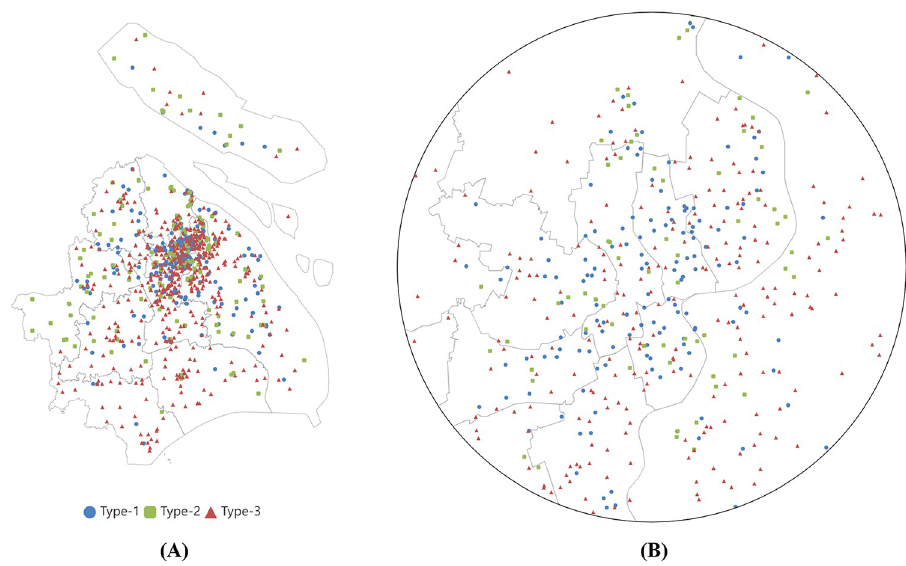
Fig 5. Geographical distribution of PSSFC with three categories in Shanghai. (A) The geographical distribution panorama of PSSFC in Shanghai. (B) The distribution of Type-1 PSSFC in Shanghai. (C) The distribution of Type-2 PSSFC in Shanghai. (D) The distribution of Type-3 PSSFC in